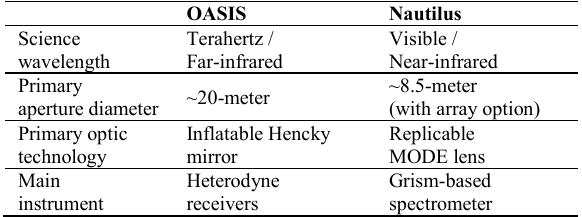
Table 1. Summary of OASIS and Nautilus